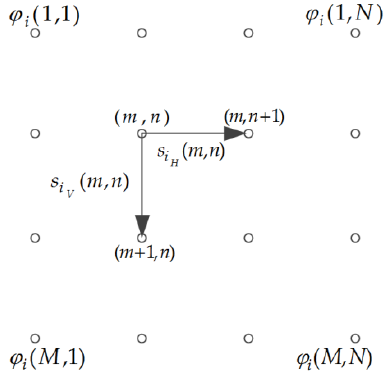
Figure 2. Two-dimensional grid associated with the interferometric phase signal.